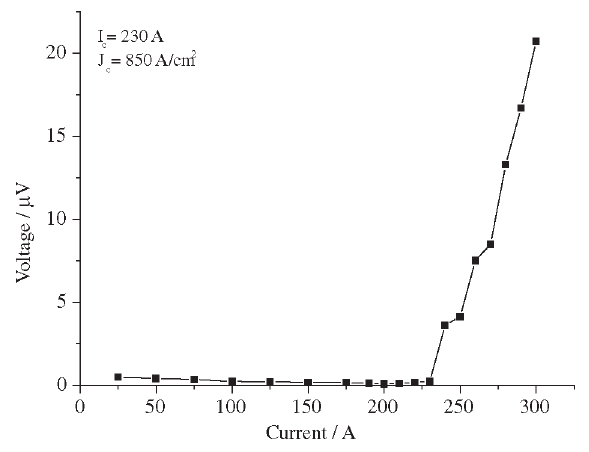
Figure 9. I terial obtained by